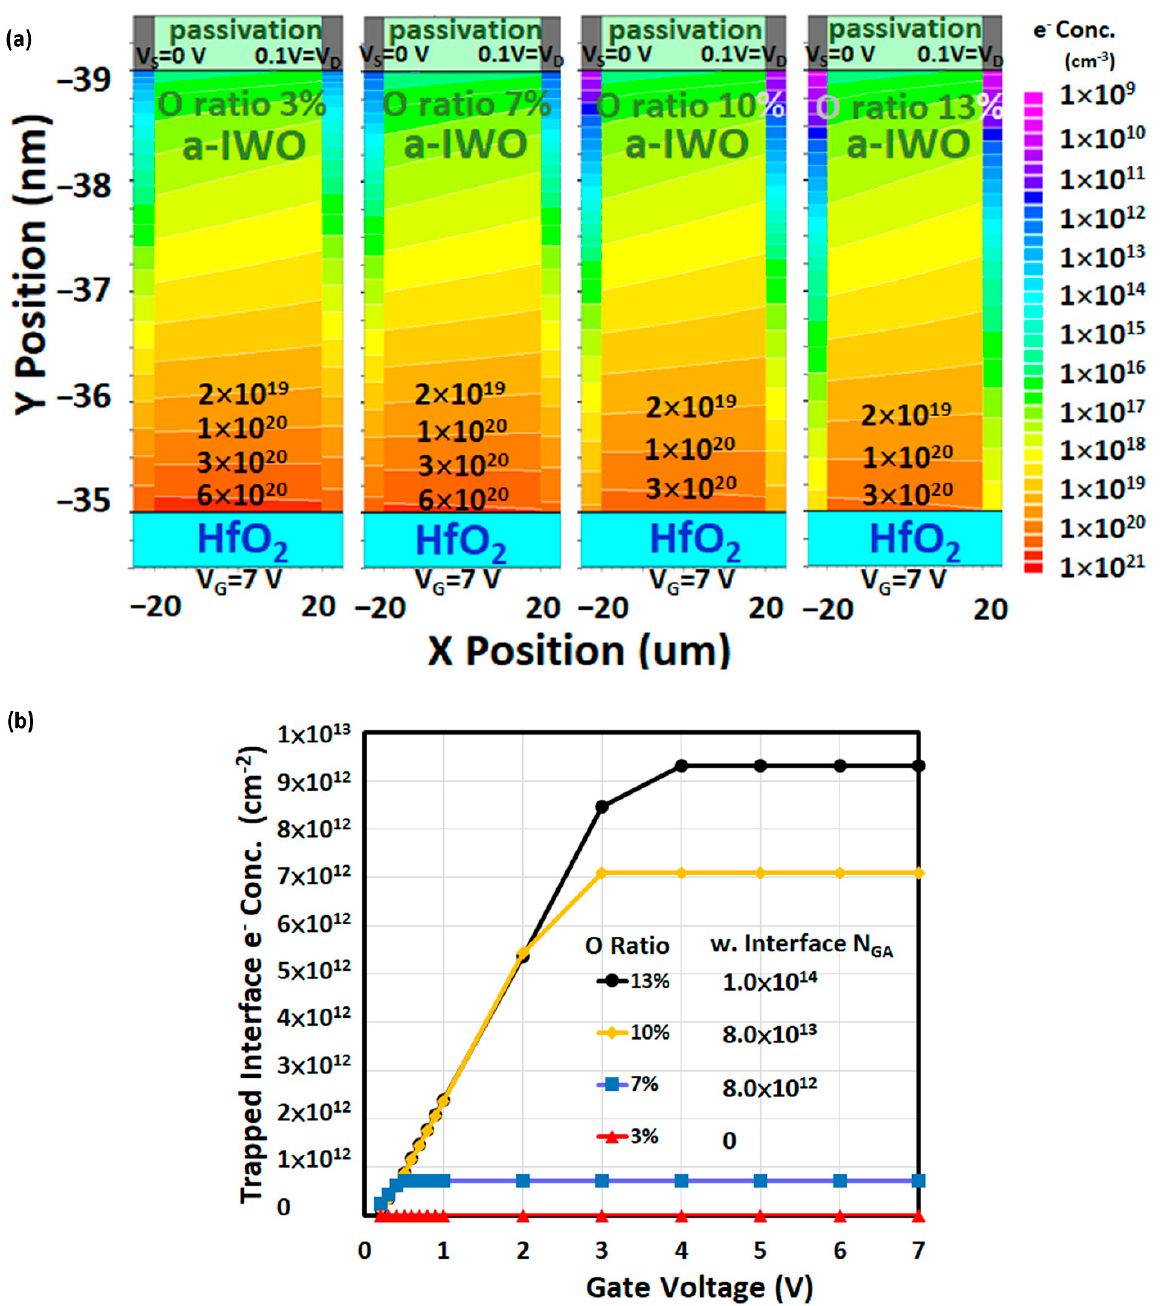
Figure 8. ( a ) The 2D simulated electron distributions inside a-IWO with different oxygen ratios in the on-state condition; ( b ) trapped interface electron concentration dependent on V G bias for four different oxygen ratios of a-IWO TFT.